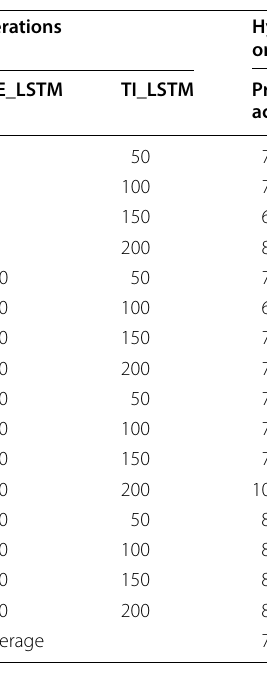
Hybrid model‑modification based on